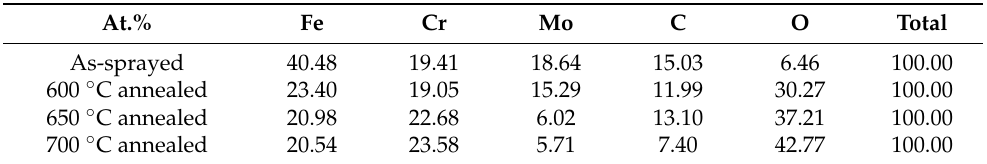
Figure 3. SEM morphologies of the Fe-based amorphous alloy coating after annealing at different temperatures: ( a ) 600 °C, ( b ) 650 °C, ( c ) 700 °C. Table 3. SEM-EDS chemical composition analysis of the Fe-based amorphous alloy coating after different annealed temperature.